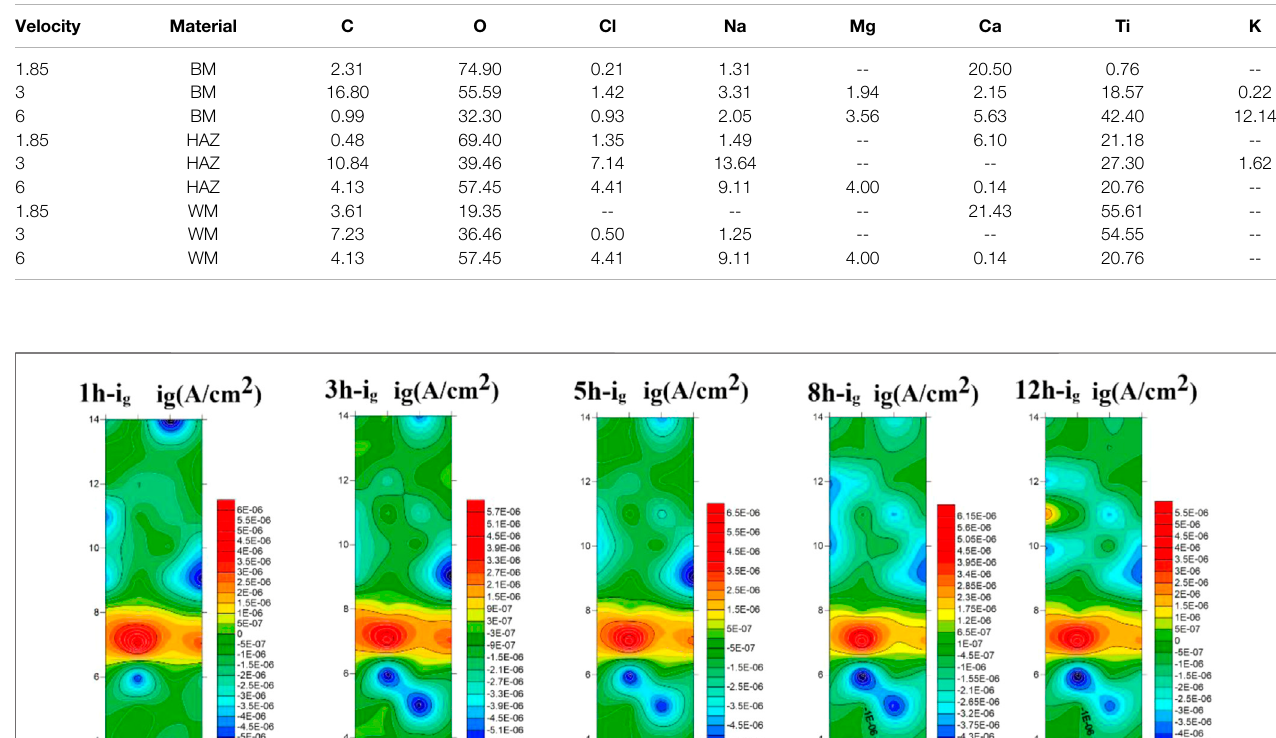
Frontiers in Materials |